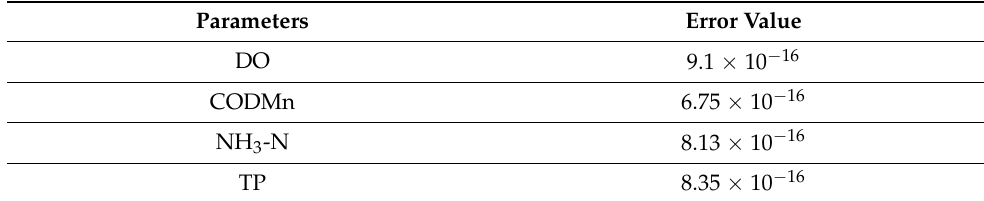
Table 4. Wavelet reconstruction error table for each parameter.